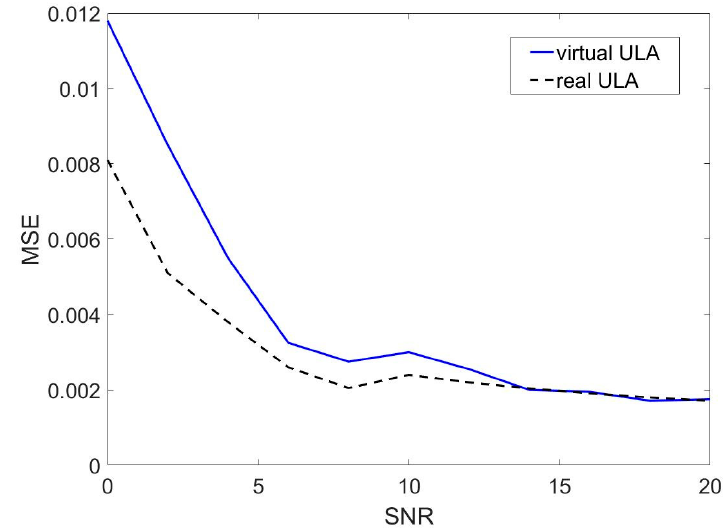
Figure 3. MSEs of virtual ULA and real ULA.